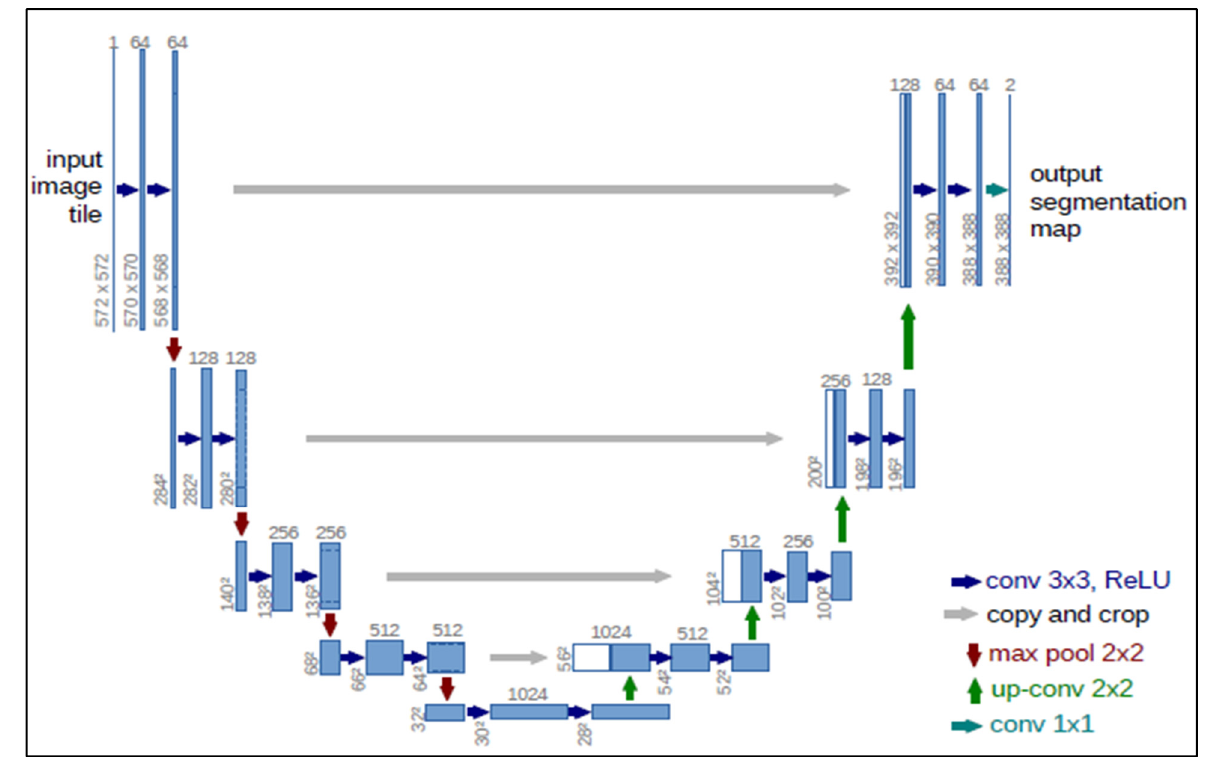
Figure 1. U-net architecture [32].